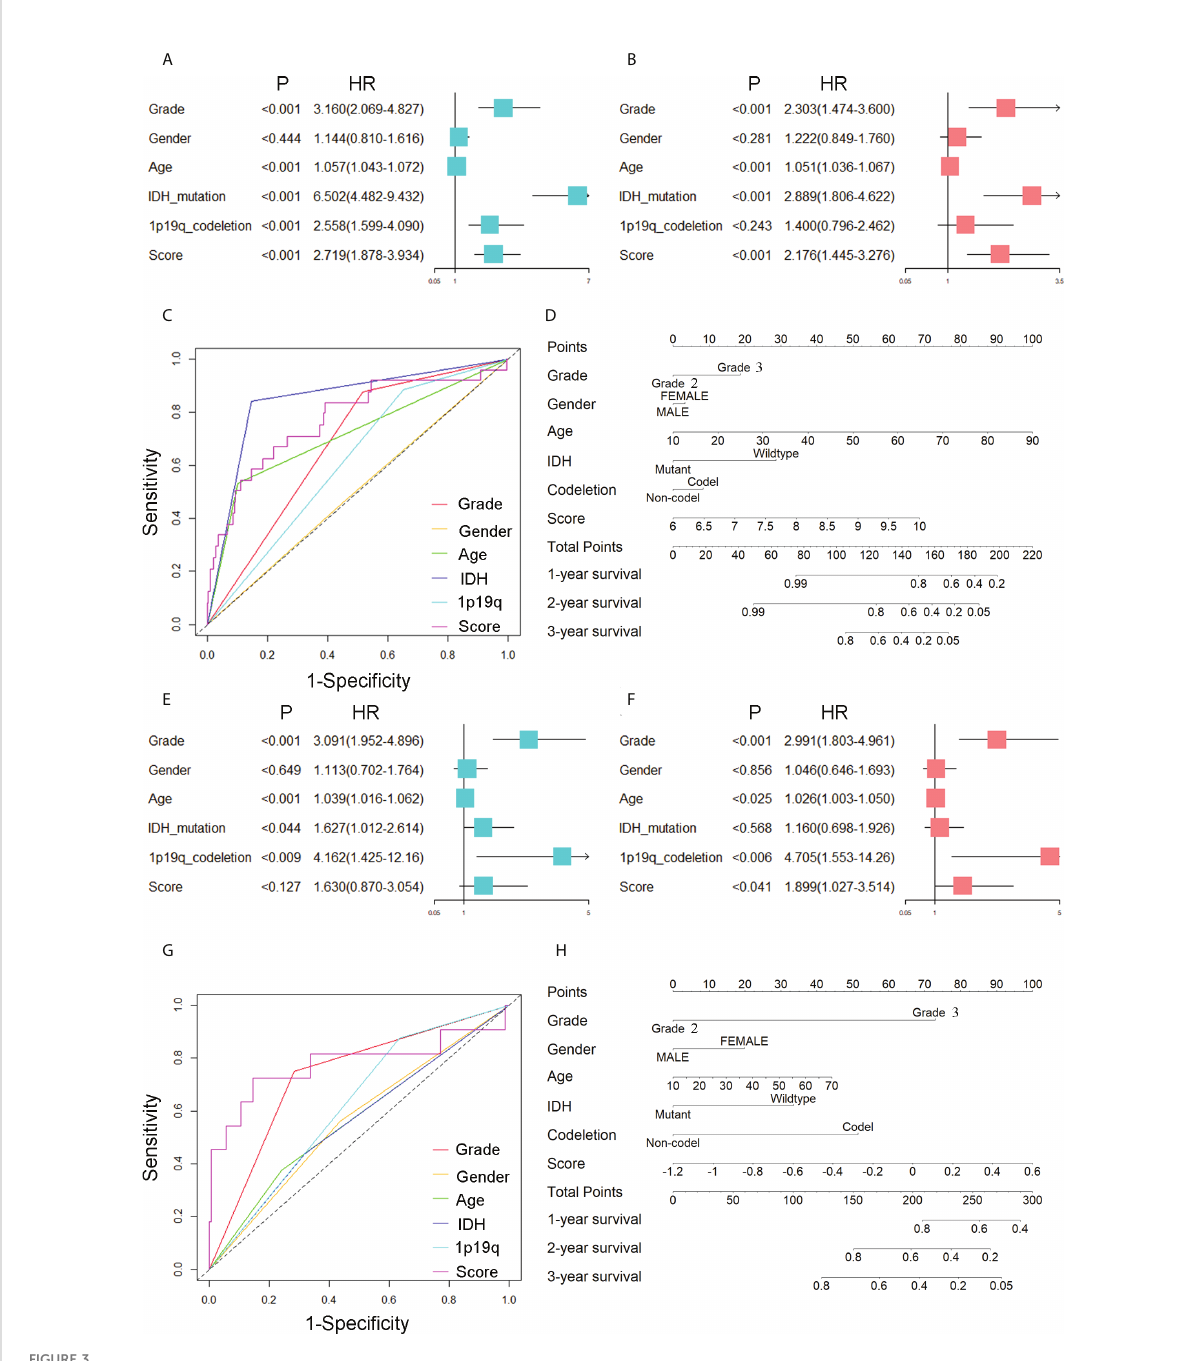
FIGURE 3 Prognostic value of CARSs. (A) Forest plot of univariate Cox regression analysis evaluating the prognostic value of risk scores and clinical factors in the TCGA cohort. (B) Forest plot of multivariate Cox regression analysis assessing the prognostic value of risk scores and clinical factors in the TCGA cohort. (C) ROC curves of risk scores and clinical factors in TCGA for predicting 1-year OS. (D) The nomogram based on the risk score and other clinical factors in the training cohort. (E) Forest plot of univariate Cox regression analysis evaluating the prognostic value of risk scores and clinical factors in the CGGA cohort. (F) Forest plot of multivariate Cox regression analysis assessing the prognostic value of risk scores and clinical factors in the CGGA cohort. (G) ROC curves of risk scores and clinical factors in CGGA for predicting 1-year OS. (H) The nomogram based on the risk score and other clinical factors in the validation